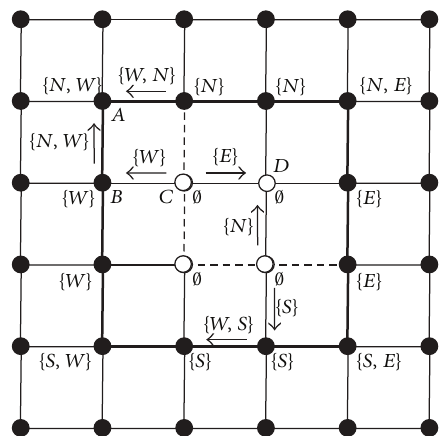
Figure 4: Construction of a cracky block depends on system message exchange. The dash line represents faulty link, and the bold line makes up the border of a cracky block. The arrow refers to the system